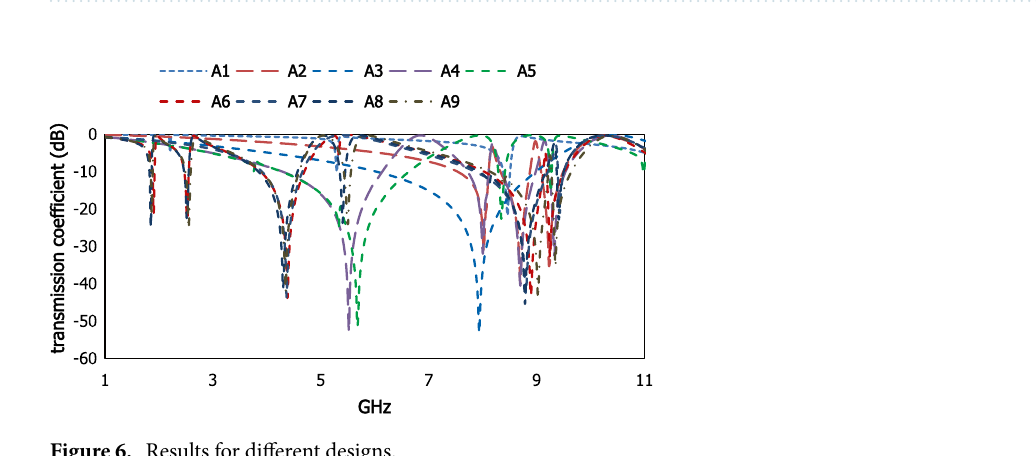
Figure 5. Design selection for the compact metamaterial resonator.